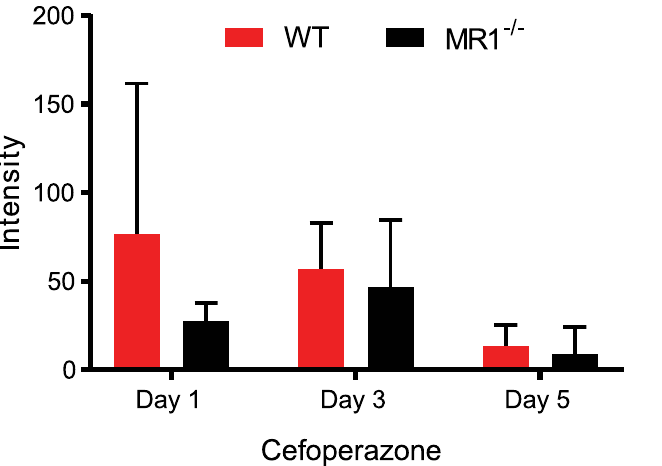
Fig 4. Cefoperazone absorption is the same in WT and MR1 -/- mice. Levels of cefoperazone in intestinal contents were analyzed by UPLC/QTof-MS after one, three and five days of antibiotic treatment. Data shown are normalized based on the total intensity of each run and are mean ± SD. Day 1: p = 0.50, n = 2 mice per groups; Day 3: p = 0.72, n = 3 mice per group; Day 5: p = 0.70, n = 3 mice per group.